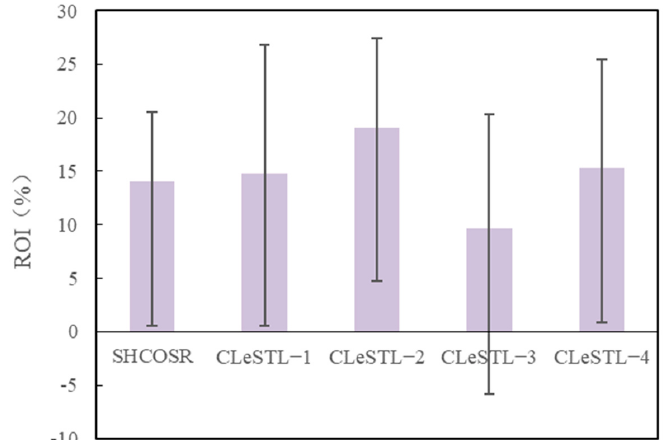
Figure 17. ROIs for CLeSTL with different scenarios.